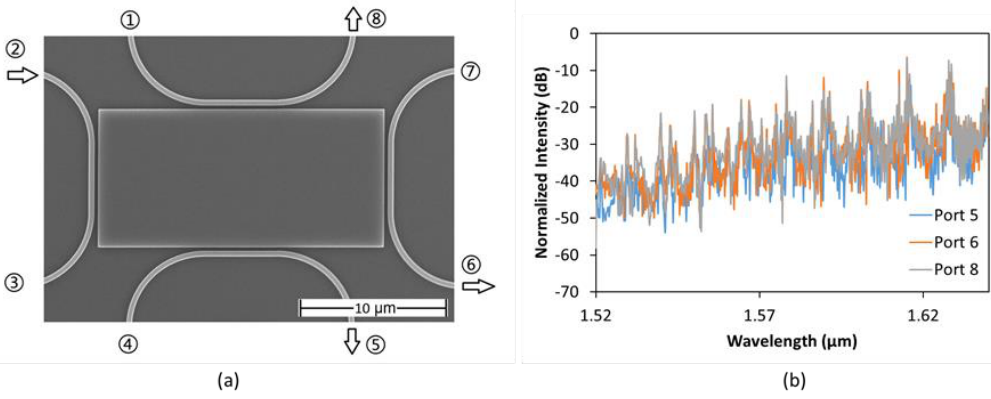
Figure 10. ( a ) SEM image of the fabricated design; ( b ) Experimental optical spectra from ports 5, 6, and 8 when port 2 is excited.